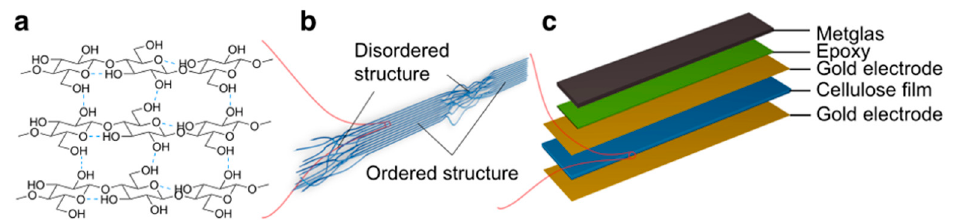
Figure 17. Schematics of the cellulose based flexible ME sensors. ( a ) Scheme of cellulose crystal II, the most common crystalline type in regenerated cellulose materials; ( b ) Illustration of cellulose fibril alignment at the cross-section of cellulose film; ( c ) cellulose based ME laminate structure. Adapted with permission from Ref. [123] and licensed under CC BY 4.0. Copyright 2017, copyright Springer Nature Limited.